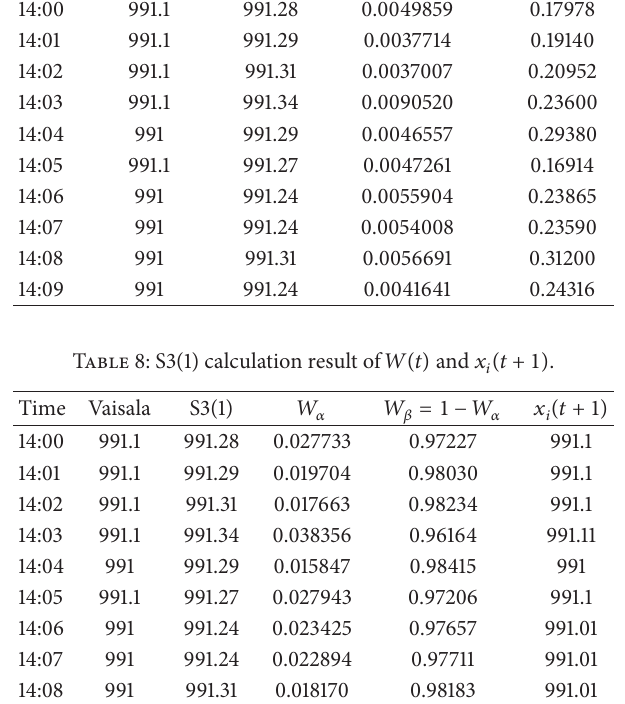
Table 7: S3(1) calculation result of variance and absolute difference. Time Vaisala